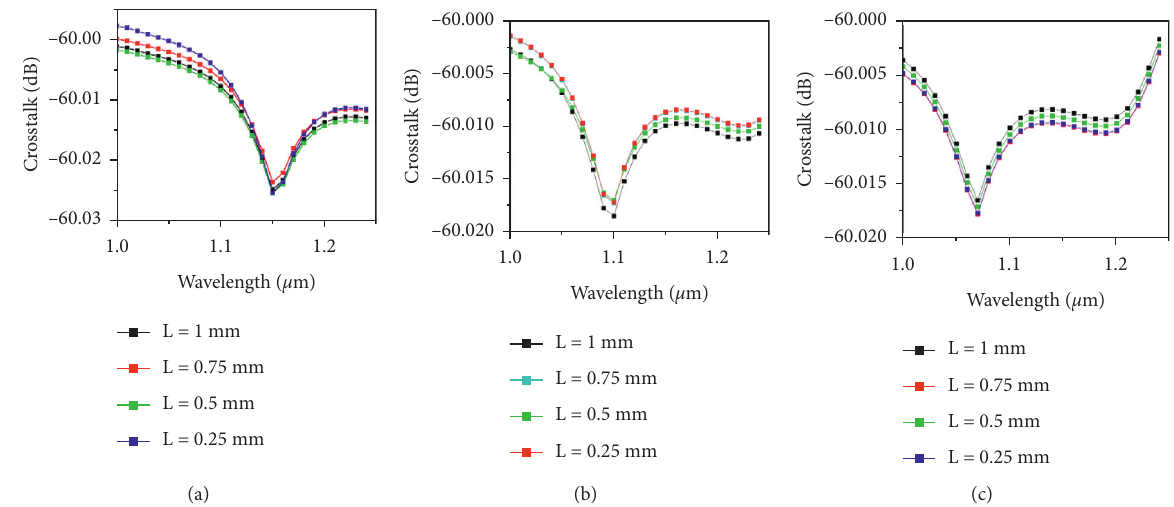
Figure 7: Crosstalk variations under changing fiber length L when (a) t